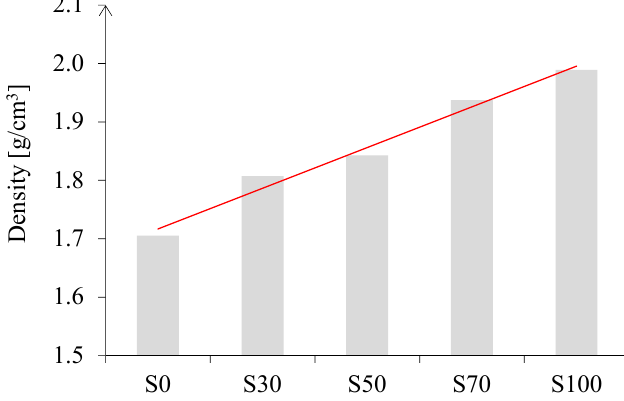
Figure 7. Density of the pastes S0, S30, S50, S70, and S100 with l/b = 0.5 in the fresh state.